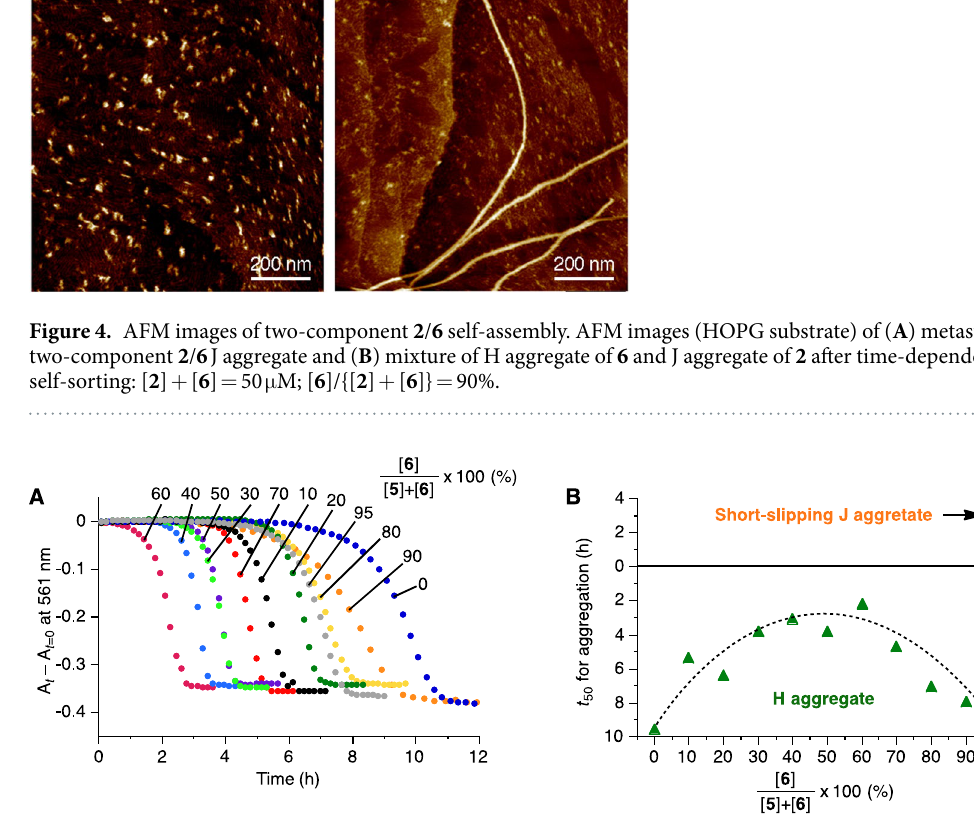
Figure 5. Kinetic studies of the self-assembly behavior of two-component 5 / 6 system. ( A ) Time profile of change in the absorbance at 561 nm, a wavelength that is characteristic of the J aggregate: [ 5 ] + [ 6 ] = 50 μ M; [ 6 ]/ {[ 5 ] + [ 6 ]} = 0, 10, 20, 30, 40, 50, 60, 70, 80, 90, and 95% as indicated. ( B ) Dependence of the mixing ratio of 5 / 6 on the lag time for the transformation of the metastable two-component 5 / 6 J aggregate. Dotted line is just for